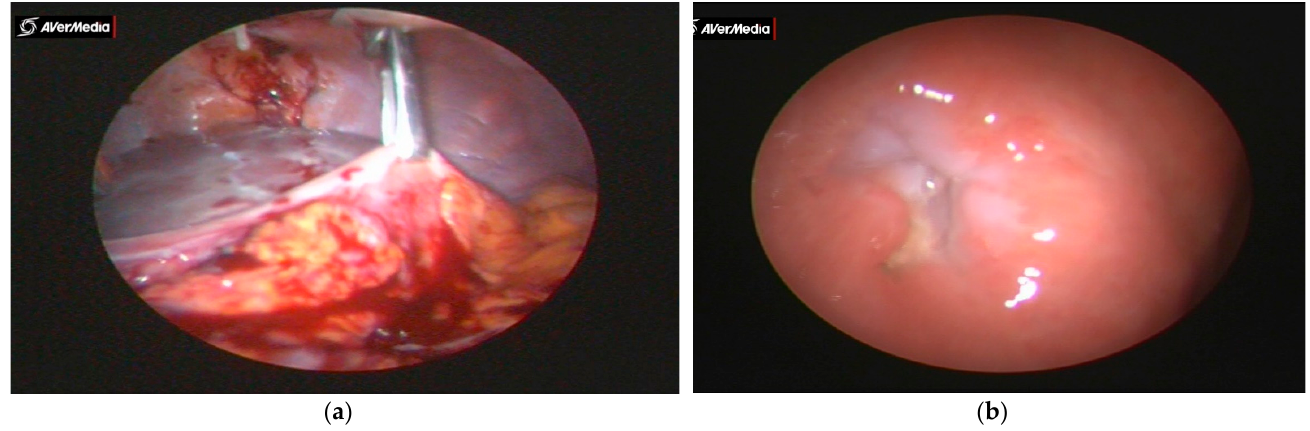
Figure 1. ( a ) Gastric anchorage with crocodile clamp and left subcostal eternalization and fixation. ( b ) Visualization of the cardia through which the telescope with the working channel and the elastic catheter are inserted in view of the cranial passage of the tumor and its oral extraction.